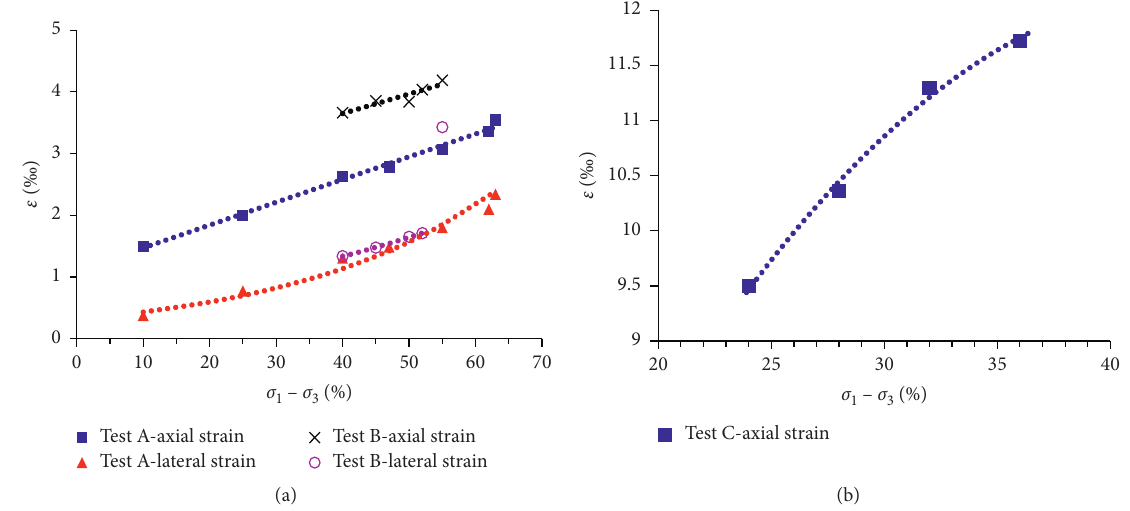
Figure 11: Variation curves of mudstone deformation with deviating stress. (a) Triaxial rheological test. (b) Uniaxial rheological